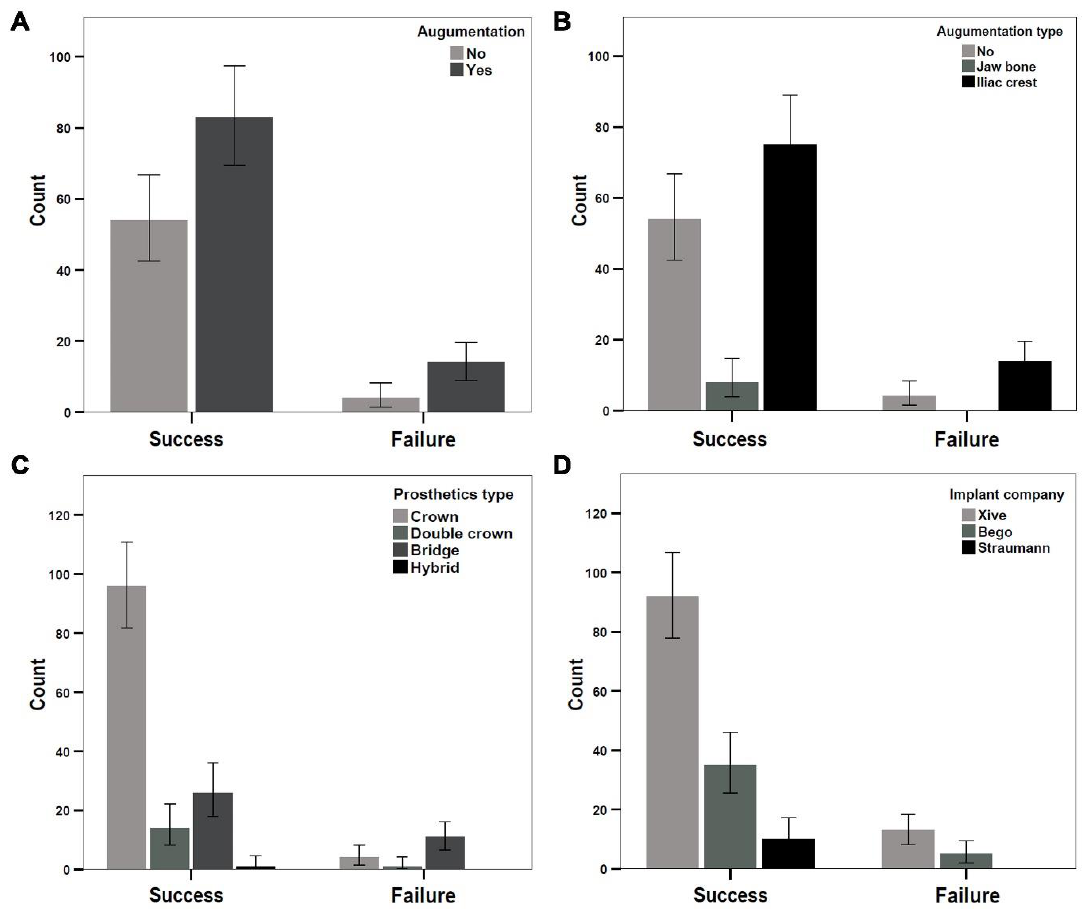
Figure 5. Frequency analysis revealed differences in the success and failure of implant materials based on the Albrektsson criteria. Implant success among patients was investigated through ( A ) the use of augmentation, ( B ) the choice of augmentation material, ( C ) the use of prosthetics, and ( D ) the choice of implant